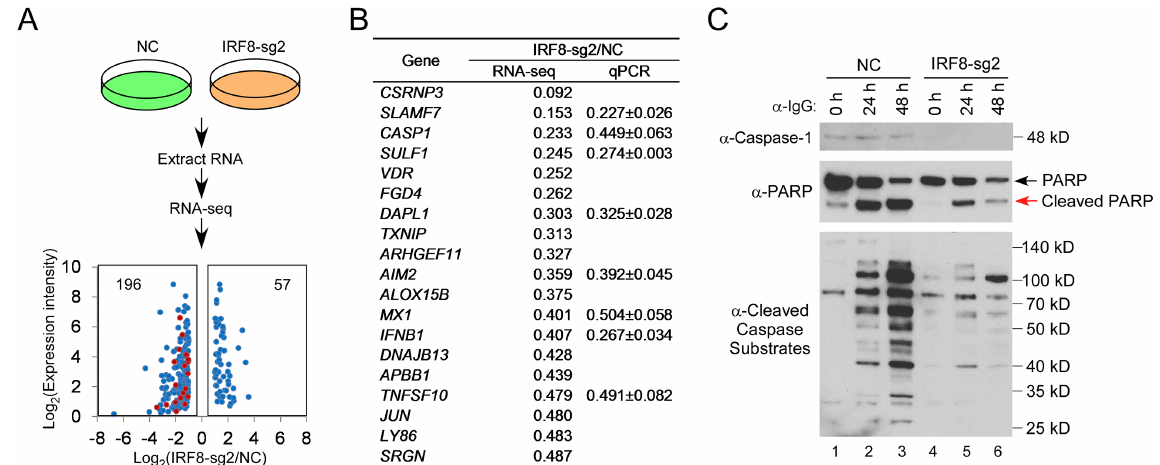
Fig 2. IRF8 depletion suppresses the expression of genes involved in apoptosis. A. Schematic representation of RNA-seq analyses of Akata (EBV + ) cells carrying control (NC) or IRF8-sg2 sgRNAs, RNAs were extracted from cells derived from three distinct lentiviral transductions. Using 2-fold change as a cutoff, 196 and 57 genes were down- or up-regulated upon IRF8 depletion, respectively. Gene Ontology analysis showing that 19 genes involved in “positive regulation of apoptosis” (red dots) were down-regulated by IRF8 depletion. B. Fold changes of the 19 apoptosis-related genes and the validation of 8 of them by RT-qPCR analysis of RNAs from cells derived from three distinct lentiviral transductions. C. IRF8 depletion (sg2) suppresses caspase-1 expression and the generation of cleaved caspase substrates upon lytic induction by anti-IgG cross-linking. Western blot analysis of protein extracts from Fig 1D using antibodies against caspase-1, PARP, and cleaved caspase substrates (Peptides containing [DE(T/S/A)D] motif) as indicated.